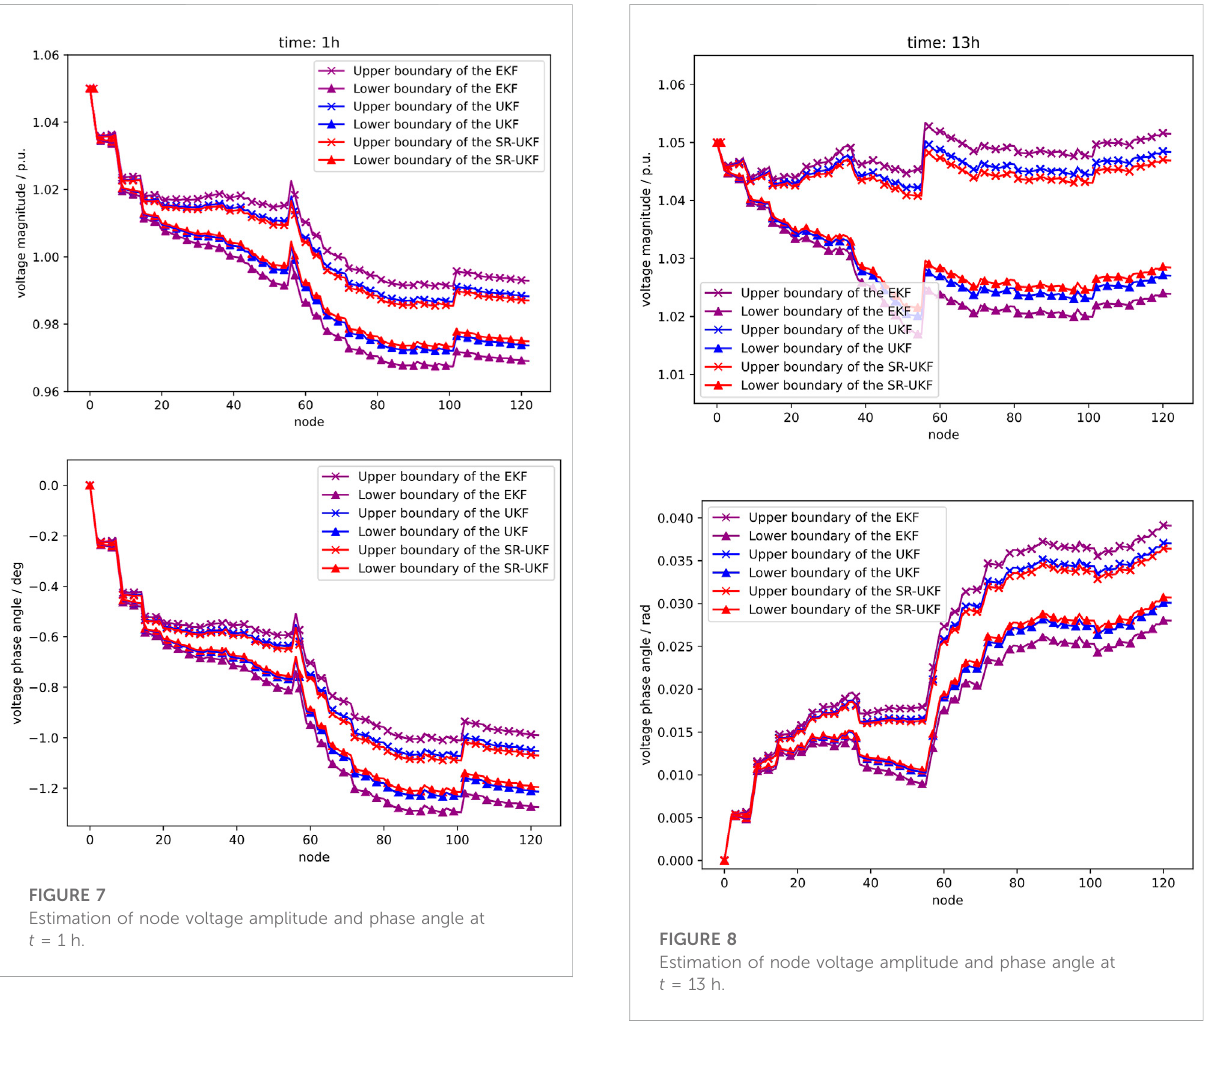
TABLE 3 Comparison bounds of node at t = 1 h